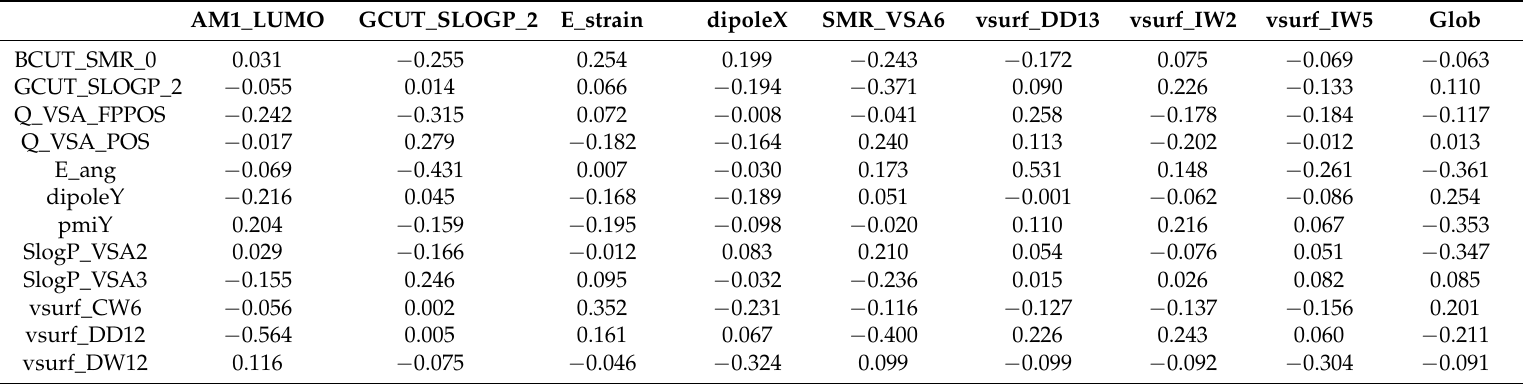
Table 5. Correlation coefficients of descriptors between two QSAR models.